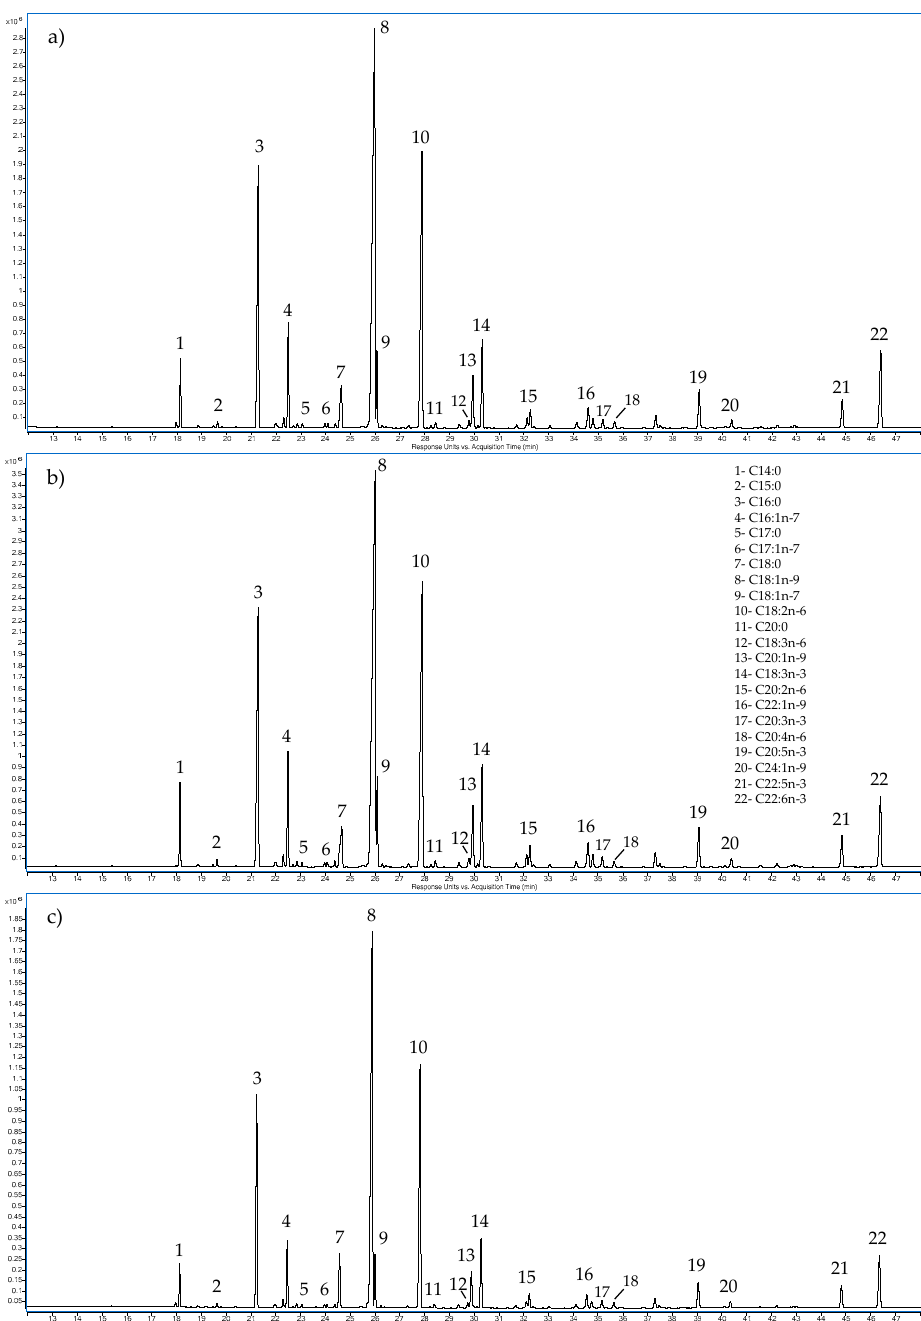
Figure 2. Chromatogram for fatty-acid analysis: ( a ) fillet; ( b ) skin; ( c ) liver. Table 4. Fatty-acid profile of sea bass fillet and by-products.